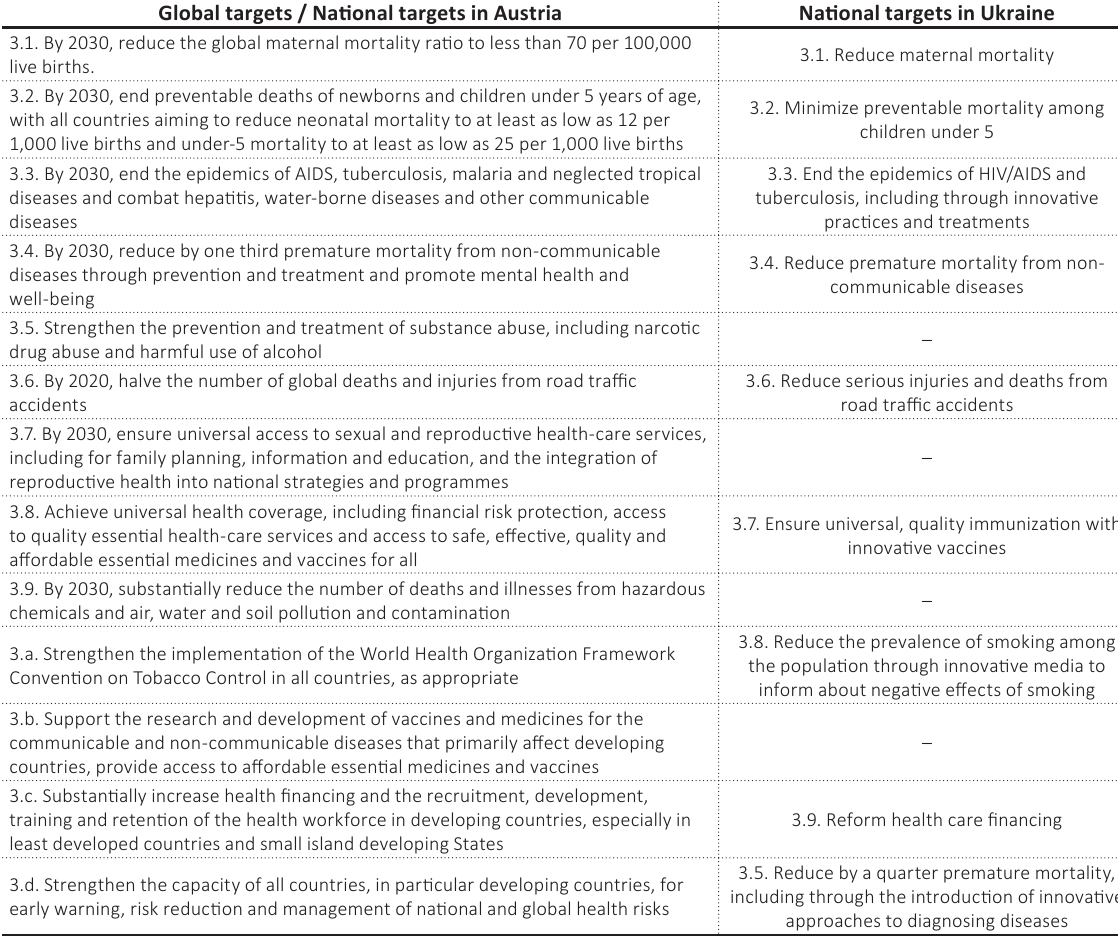
Table A1. Correspondence of global and national SDG 3 targets in Austria and